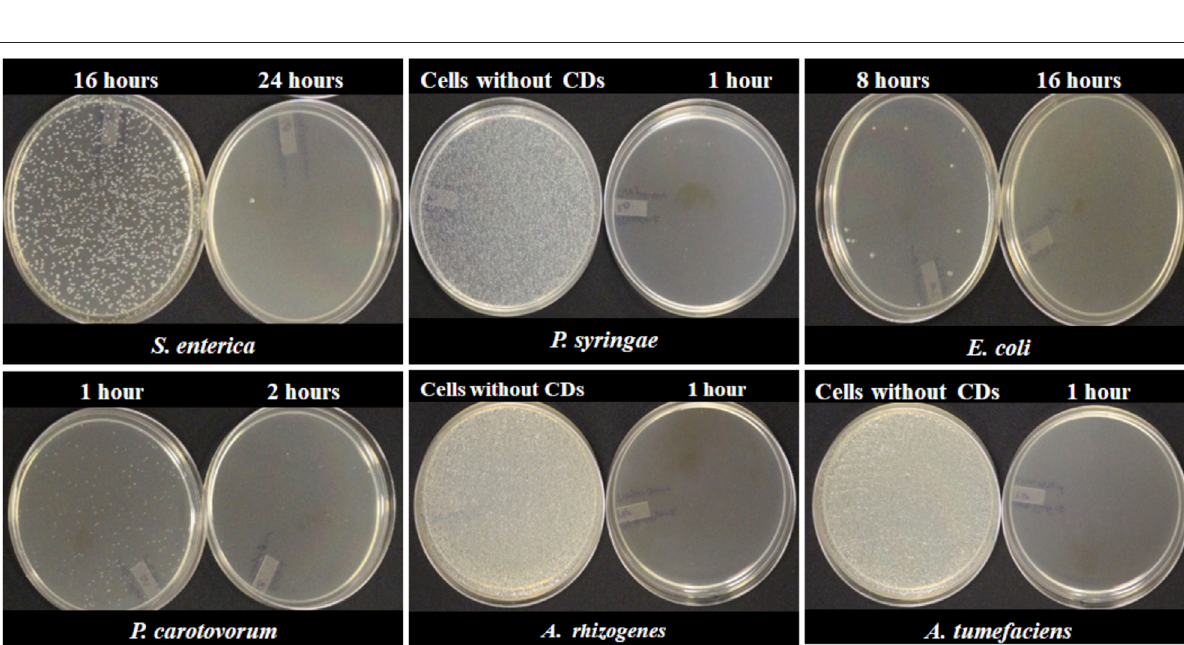
Frontiers in Nanotechnology |